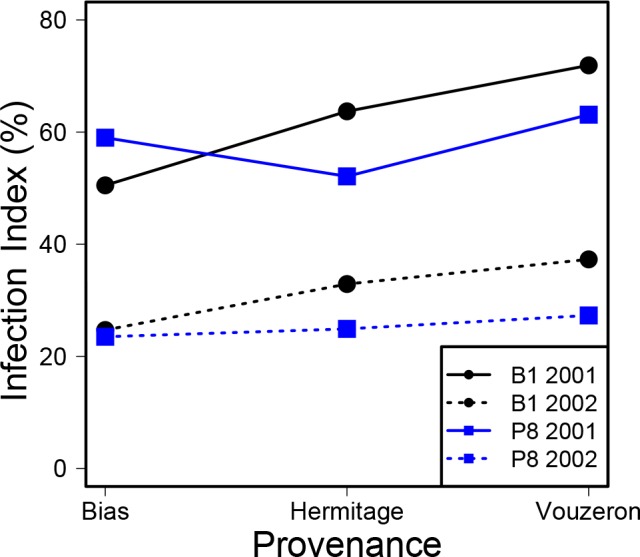
Mean infection index, by site, year and provenance.The black lines and dots are for the B1 site, the blue lines and squares are for the P8 site. The continuous and dotted lines are for 2001 and 2002, respectively.